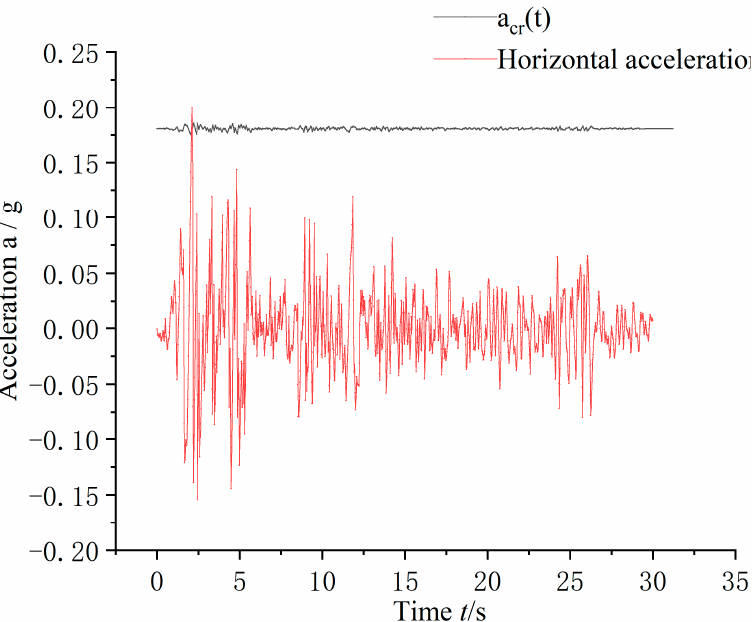
Figure 13. The horizontal acceleration and positive critical acceleration of the calculation model.